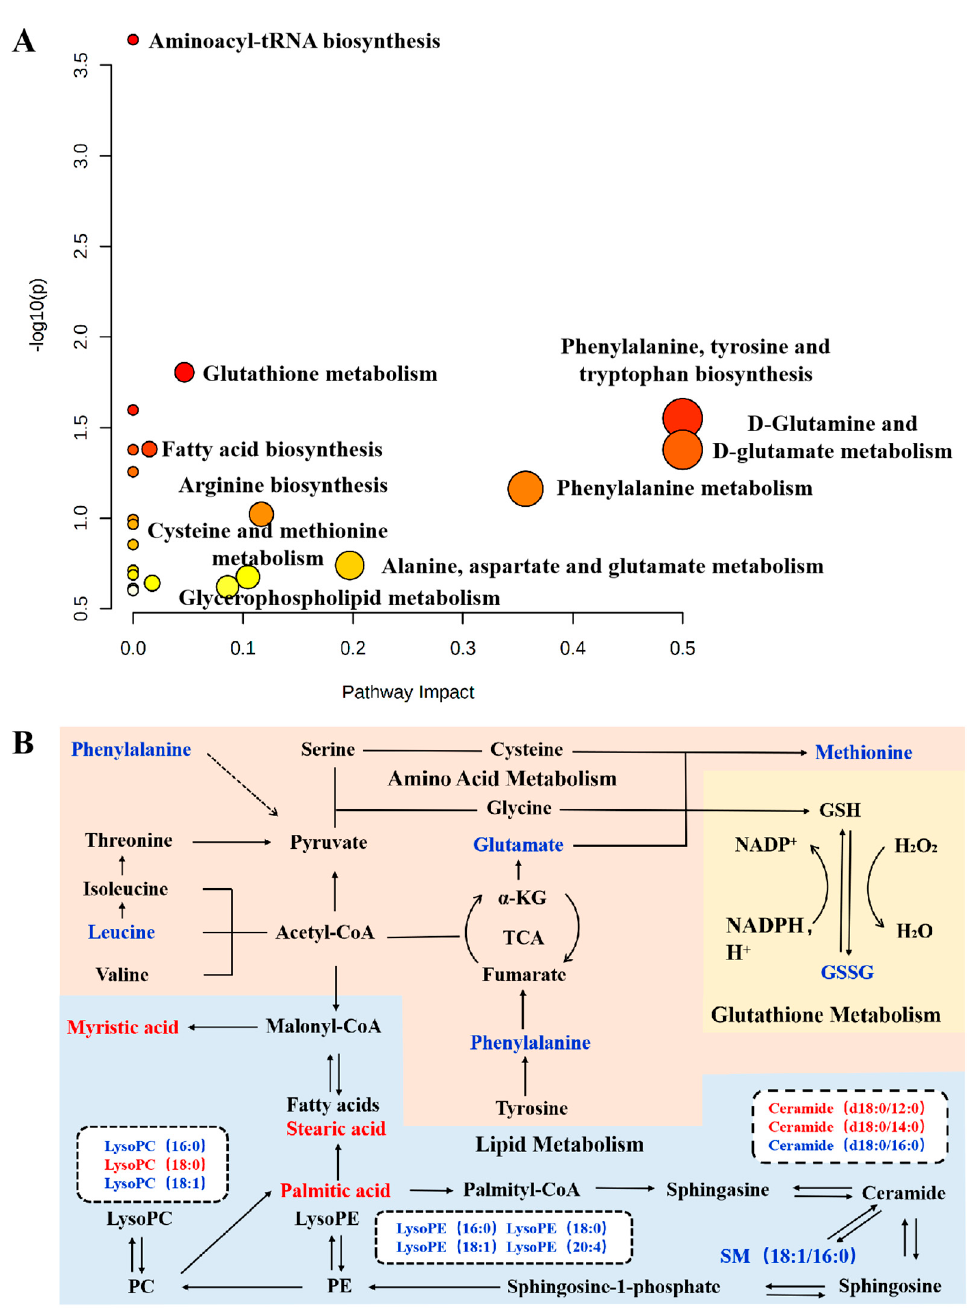
Figure 3. ( A ) Metabolic pathway analysis using Mataboanalyst 5.0; ( B ) Schematic diagram of the altered metabolites and potential disturbed metabolic pathways. Up-regulated metabolites detected are shown in red; down-regulated metabolites detected are shown in the blue. Abbreviations: α -KG, alpha-ketoglutaric acid; PC, phosphatidylcholine; PE, phosphatidylethanolamine; TCA, tricarboxylic acid; SM, sphingomyelin.